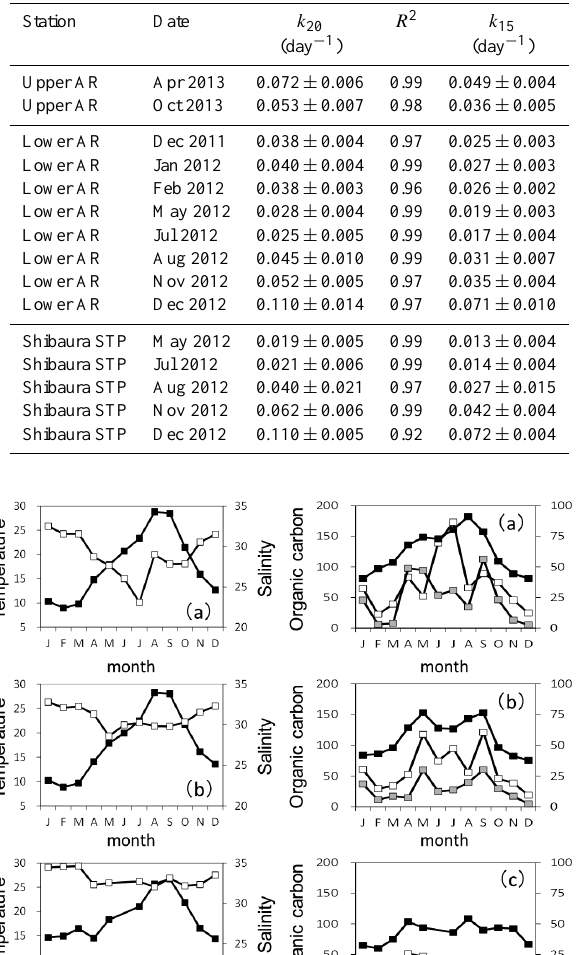
Table 2. Degradation constants for DOC ( k 20 ) and normalized degradation constants at 15 ◦ C ( k 15 ) ± standard deviation at the upper Arakawa River (upper AR), the lower Arakawa River (lower AR), and Shibaura STP stations. R 2 indicates coefficient of deter- mination.